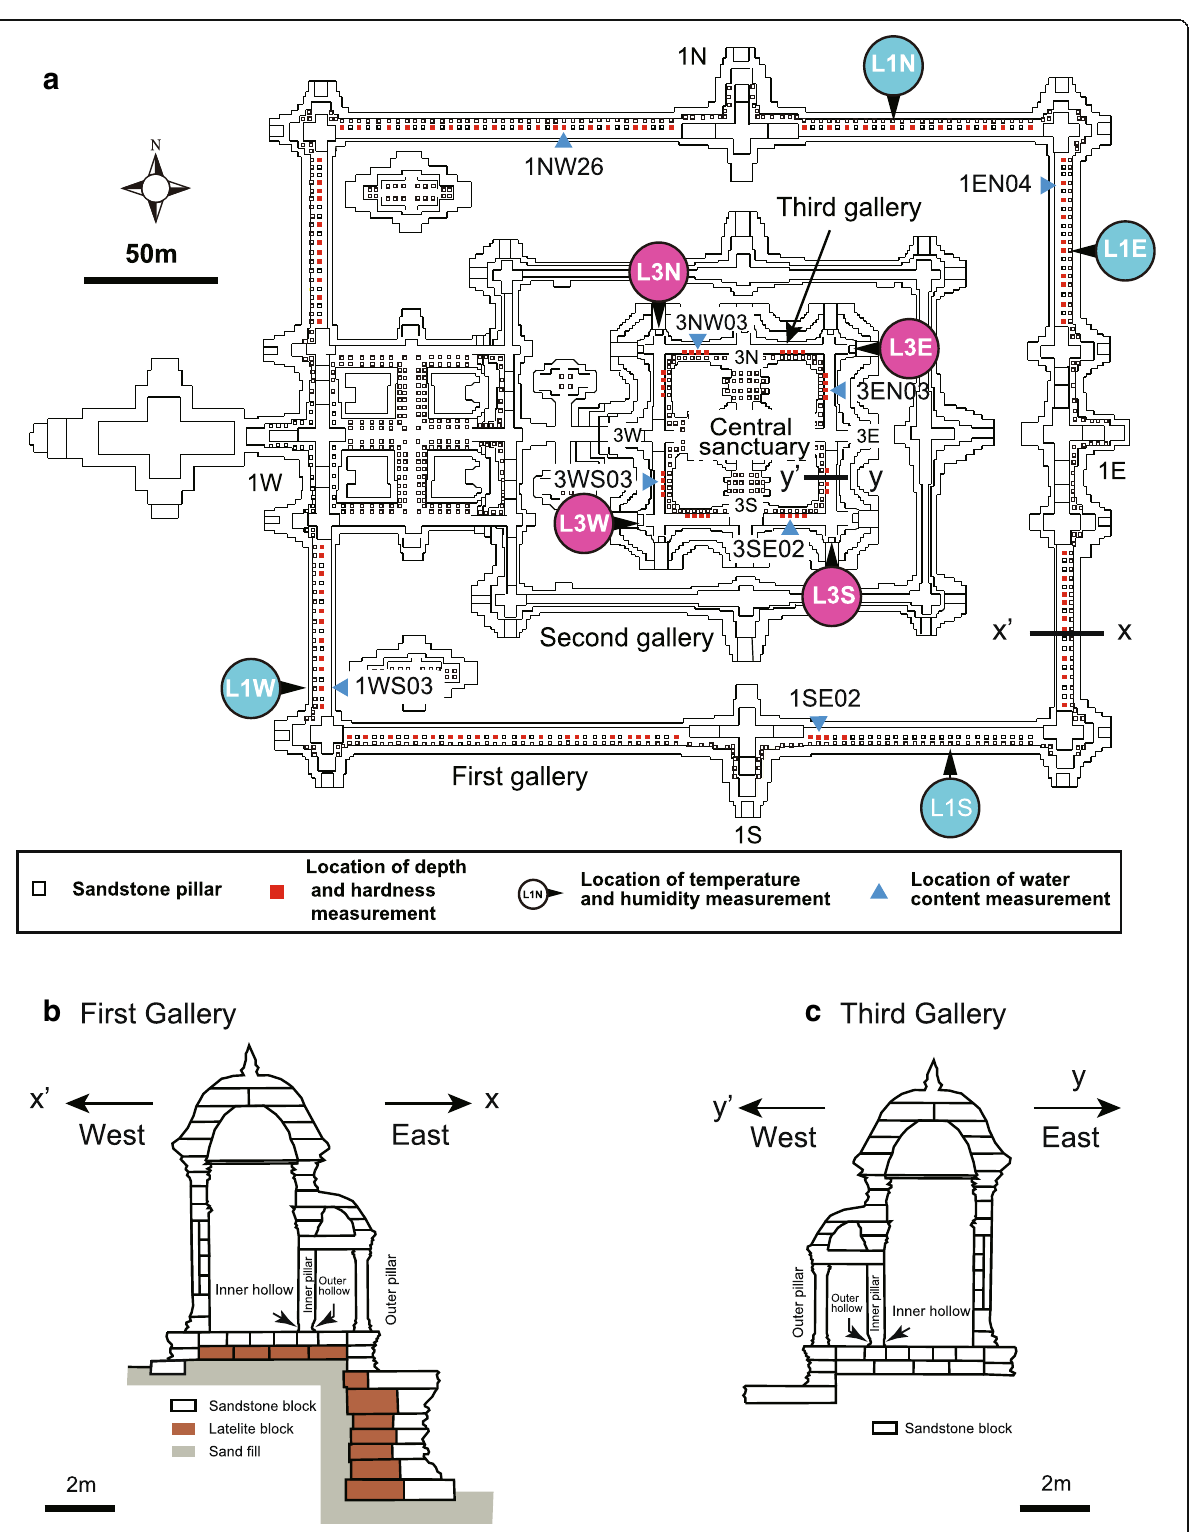
Fig. 2 A plan of the galleries ( a ) and conceptual cross sections of the first ( b ) and the third galleries ( c ). The plan was modified from Glaize (1963). The inner pillars that measured the hollow depth and hardness are shown in red squares. The air temperature and humidity measurements using data loggers were carried out on the beam. The water contents were measured at eight inner